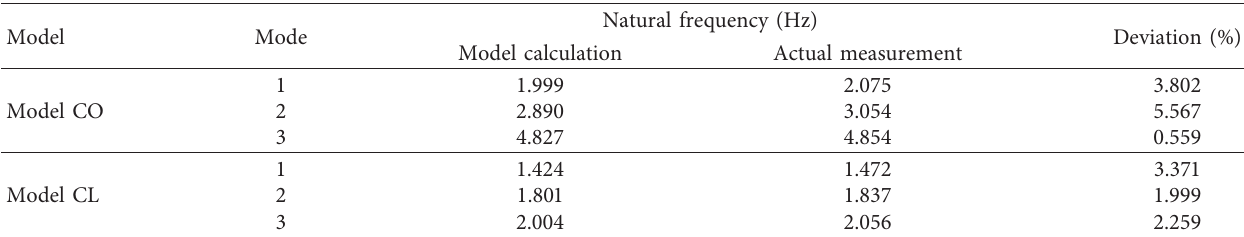
Figure 5: Position of the sensor on the climbing Table 5: Comparison between model results and actual measurement results.